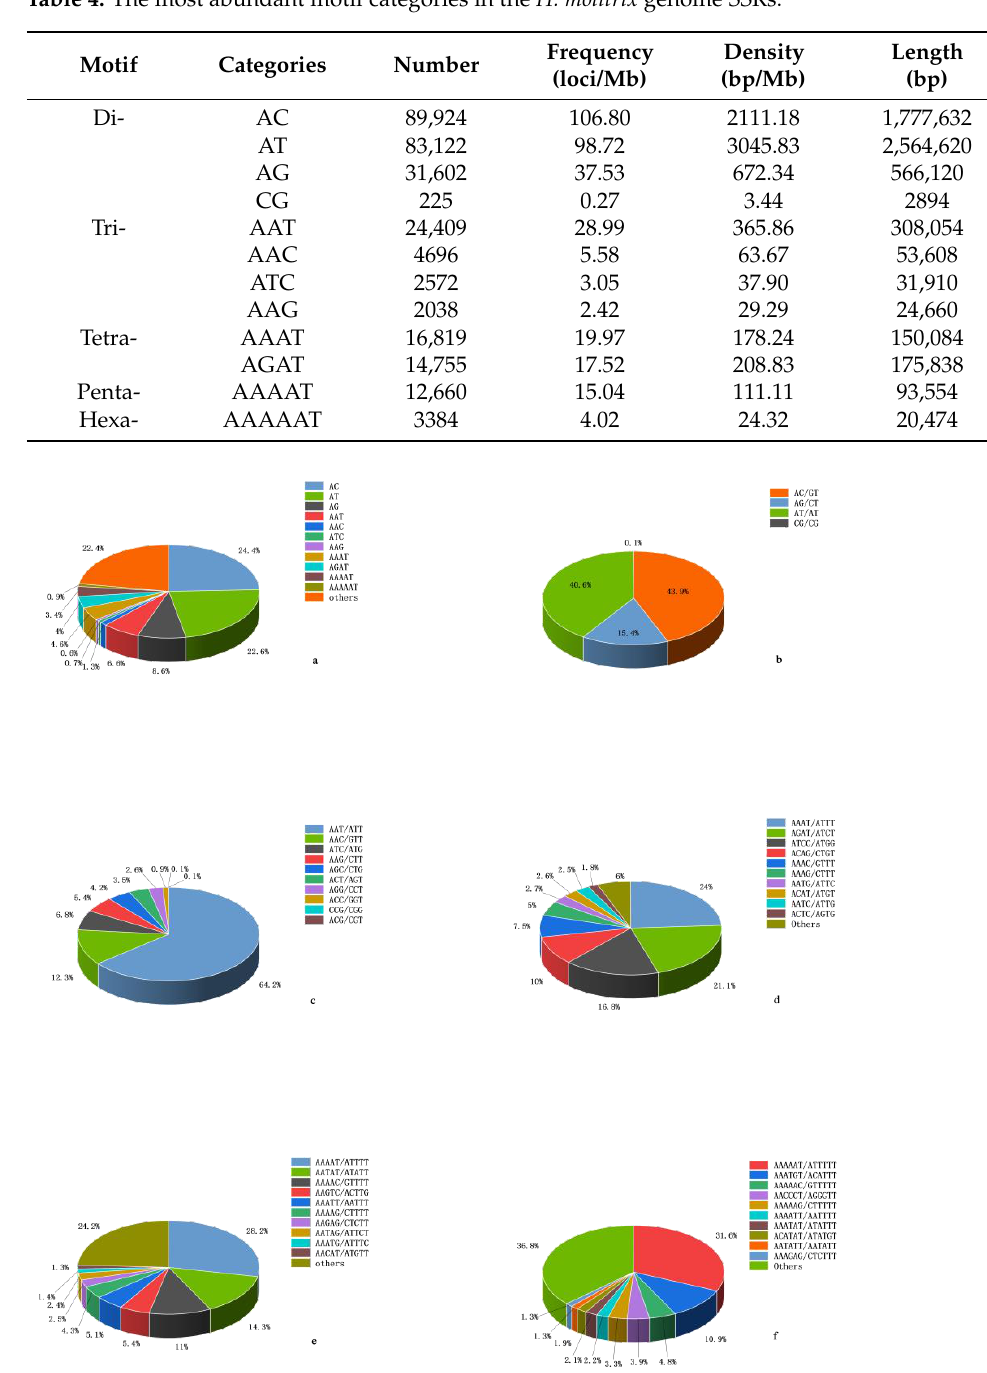
Table 4. The most abundant motif categories in the H. molitrix genome SSRs.